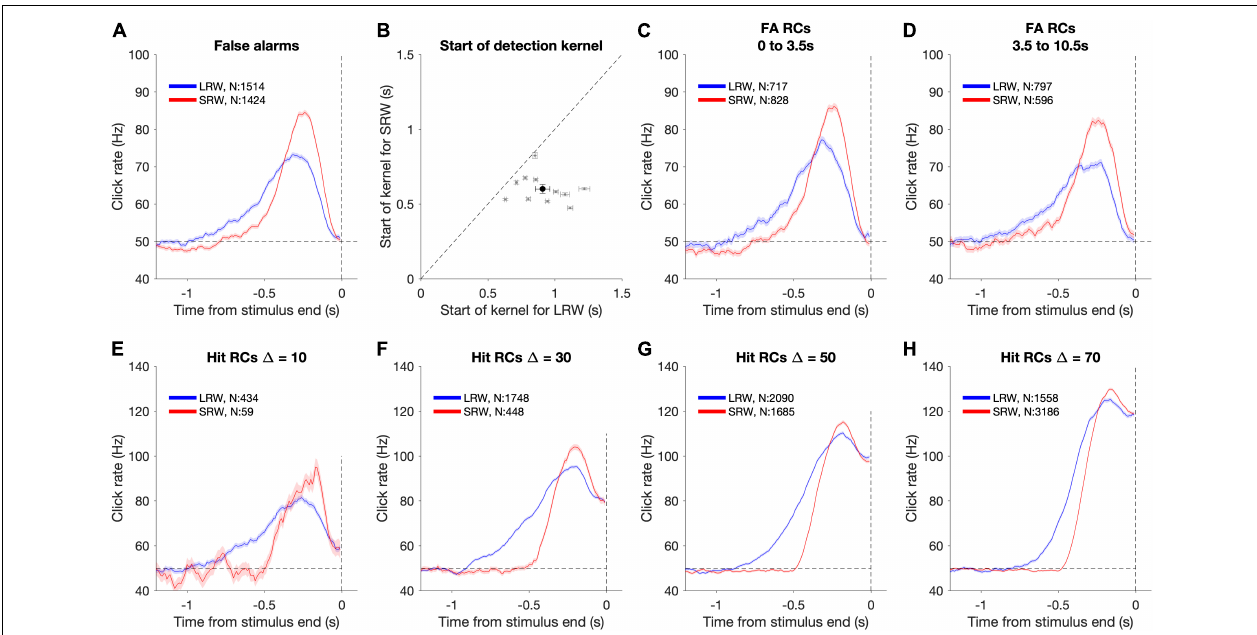
FIGURE 3 | Using detection report kernels to compare the timescales of evidence evaluation between the task conditions. (A) Detection report kernel in the LRW (blue) and the SRW (red) conditions (data pooled across subjects, N shows number of trials). Shaded regions indicate the standard error of the mean. (B) Pairwise comparison of the start of detection report kernels between the task conditions. Gray points show individual subjects. Error bars for individual subjects indicate the standard error of the estimated start point. The black point shows the population average, and its error bar indicates the standard error of the mean across subjects. (C) Detection report kernels for false alarms occurring within the first 3.5 s of the trial. (D) Detection report kernels for false alarms occurring after 3.5 s from trial start. (E–H) Detection report kernels for hit trials with each panel for a different (cid:49) . Same conventions as panel (A)